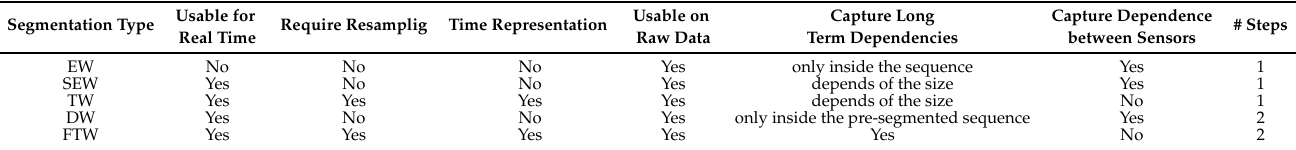
Table 1. Summary and comparison of segmentation